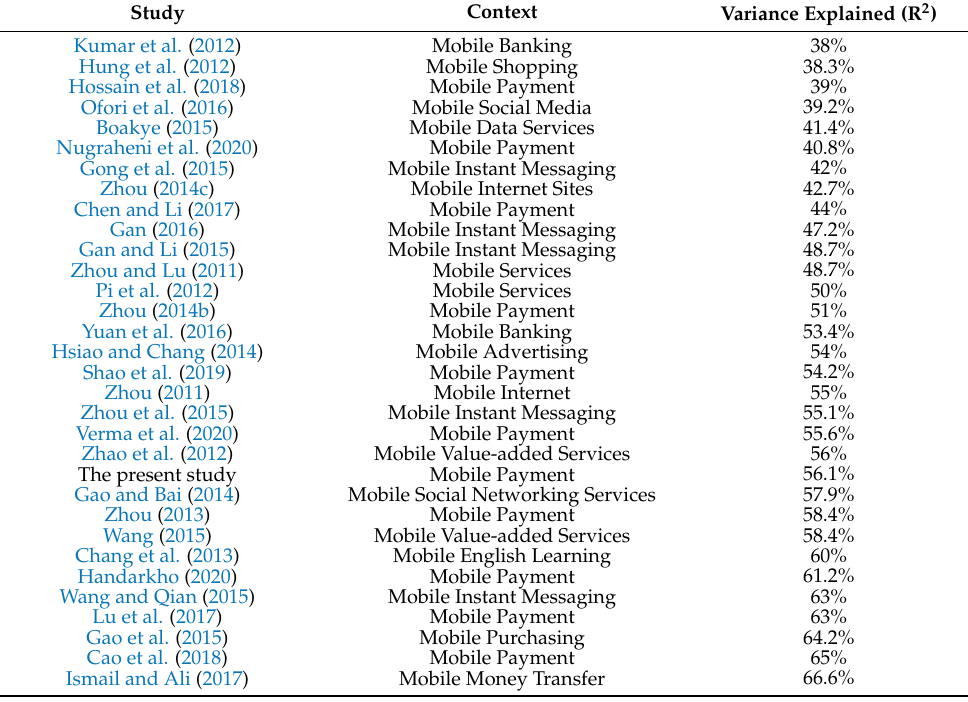
Table 8. Reported variance explaining continuance intentions towards mobile technologies †